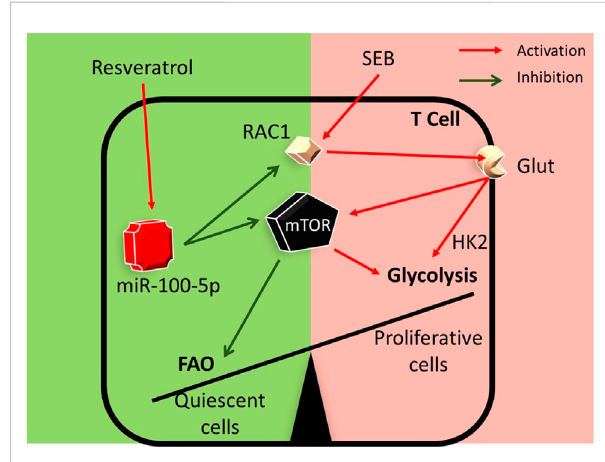
Graphical abstract: RES may suppress SEB-mediated hyperimmune response through the following pathway: RES induces miR-100 in activated immune cells which leads to decreased expression of Mtor, Rptor, and Rac1 genes. During T-cell activation, Mtor induces the transcription of many key glycolytic enzymes. mTOR regulates metabolic pathways through theactivation of downstream transcriptional factors. Such transcription factors play a key role in the metabolic switch by promoting the expression of enzymes involved in aerobic glycolysis and other anabolic pathways involved in T cell activation and differentiation (Palmer et al., 2015). Thus, RES by suppressing mTOR pathway may alter the metabolic programming in SEB-activated T